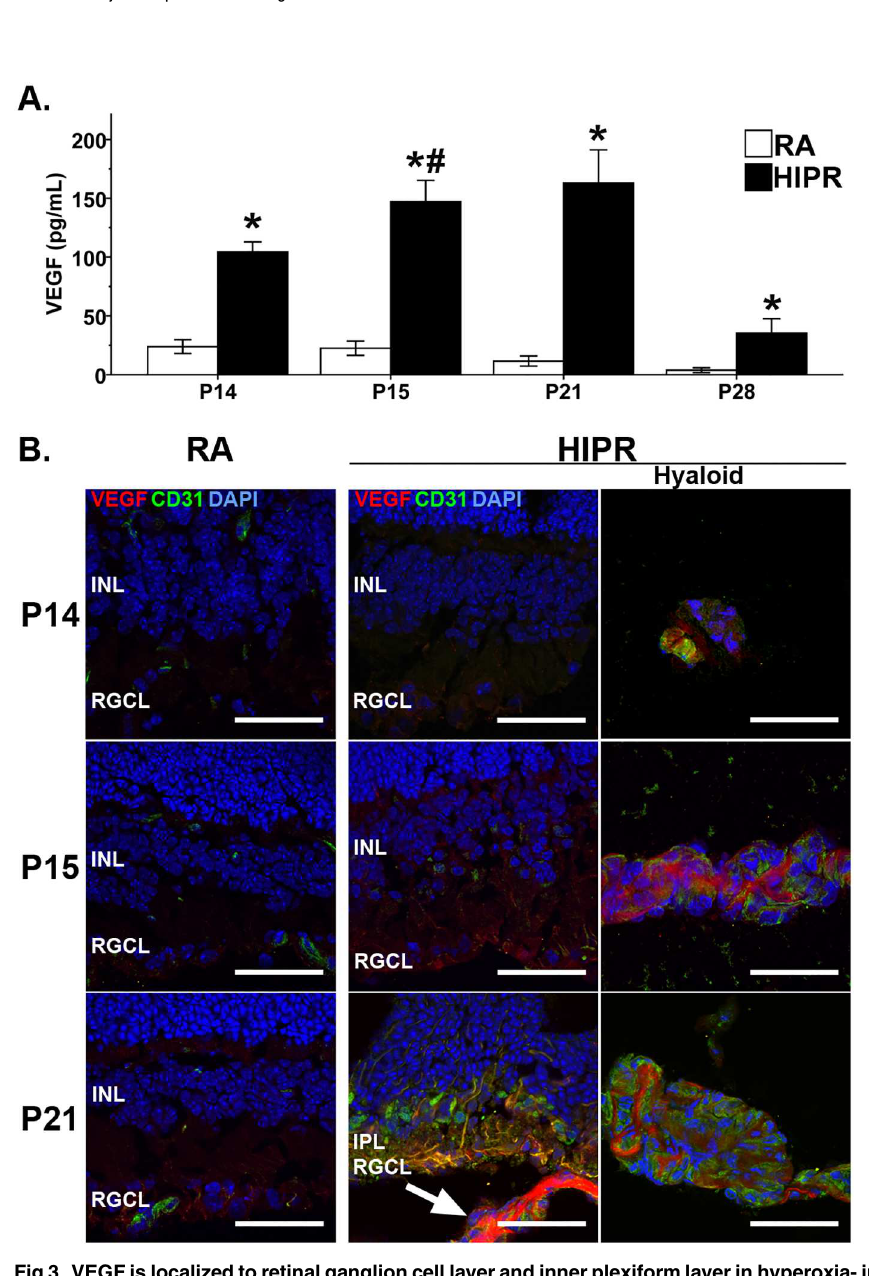
Fig 3. VEGF is localized to retinal ganglion cell layer and inner plexiform layer in hyperoxia- induced proliferative retinopathy retinas. (A) Retinal proteinVEGF levels were quantifiedwith an ELISA. VEGF increaseduntil P21 and then decreased. Valueswere mean ± SEM (N = 4). # p < 0.05HIPR P15 comparedto HIPR P14. * p < 0.05HIPR to respectiveage-matched RA controls. § p < 0.05 HIPR P21 comparedto HIPR P15. (B) Sections were immunostained with VEGF (red) and co-stainedwith an endothelialcell marker, CD31 (green), and DAP1 (blue, N = 2). VEGF was found in the RGCL at P15 and mainly in IPL at P21. Persistent hyaloidal vessels stainedstrongly for VEGF and CD31and these hyaloidal vessels were in close proximity to the inner retina (arrow). INL, inner nuclear layer. RGCL, retinal ganglioncell layer. IPL, inner plexiform layer. Scale bar, 50 μ